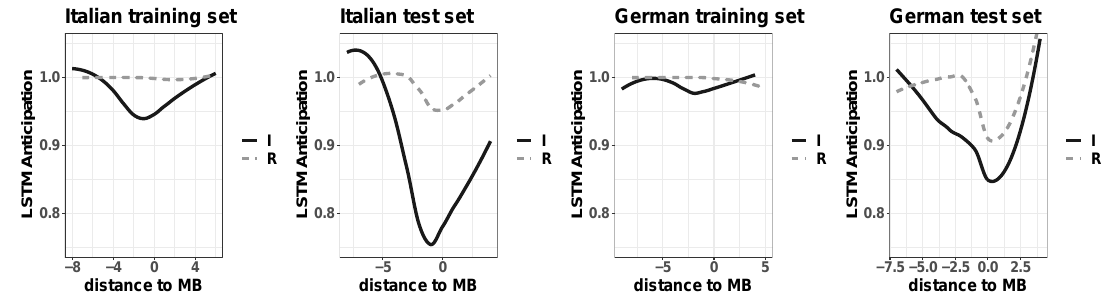
Figure 3. Regression plots of interaction between morphological (ir)regularity (Regulars versus Irregulars) and distance to morpheme boundary (MB) in non-linear models (GAMs) fitting the number of correctly anticipated symbols by the trained LSTMs on Italian ( left plots ) and German ( right plots ) for training and test